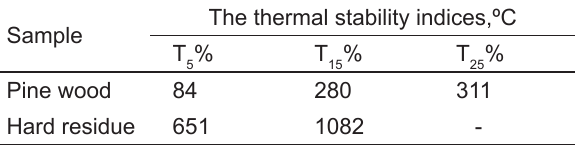
6. The thermal stability indices (T T %) of shell 25